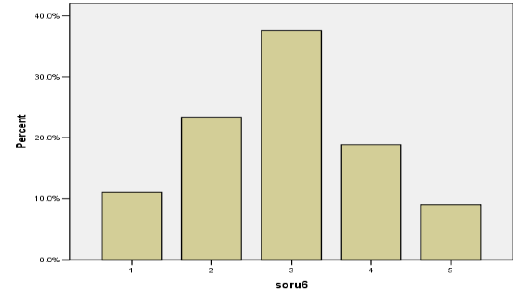
Figure 6: Is the ratio of TCC and TAS courses sufficient to all courses included in higher